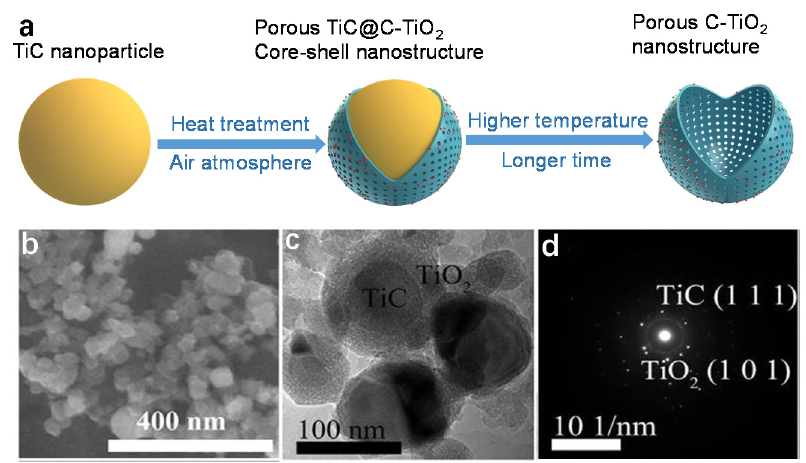
Figure 5. Preparation process ( a ), SEM ( b ), TEM ( c ), and SAED pattern ( d ) of porous C-TiO 2 nanostructure. Reprinted with permission from Ref. [15].